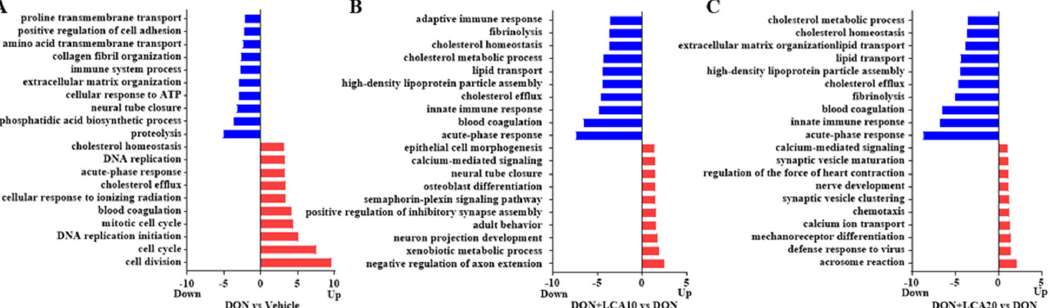
Figure 2. LCA alleviates the dysregulation of cholesterol homeostasis induced by DON. The genes involved in the cholesterol homeostasis pathway and cholesterol efflux pathway were the most abundant using GO analysis. ( A ) DON versus vehicle; ( B ) DON + LCA10 versus DON; ( C ) DON + LCA20 versus DON. Red and blue represent the upregulated or downregulated signaling pathways when comparing DON versus vehicle, DON + LCA10 versus DON, or DON + LCA20 versus DON,